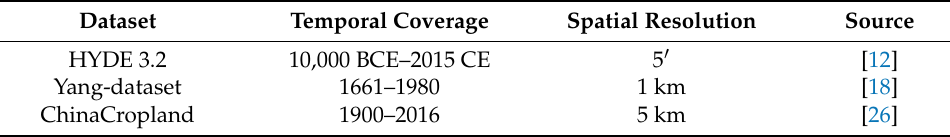
Table 2. Global and national public cropland datasets used in the comparison.